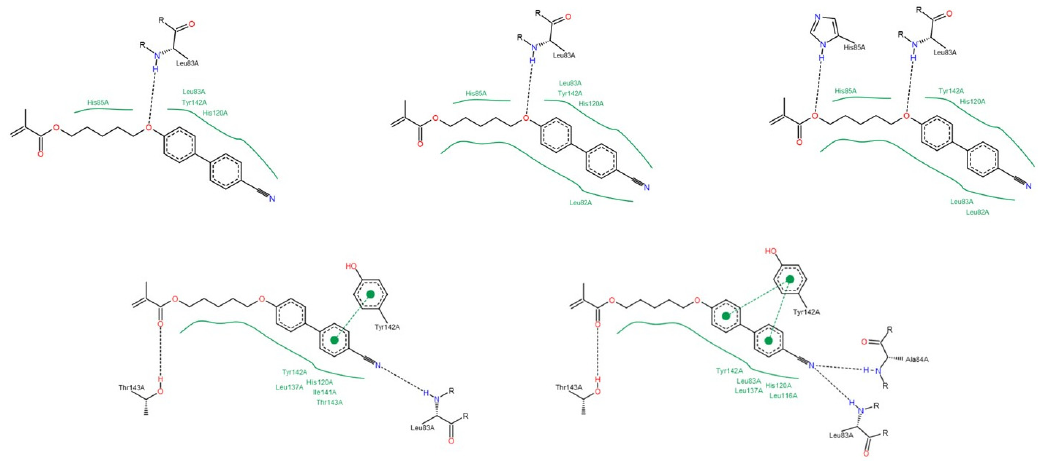
Figure A11. Interactions between compound B and MMP-1, by PoseView calculations.